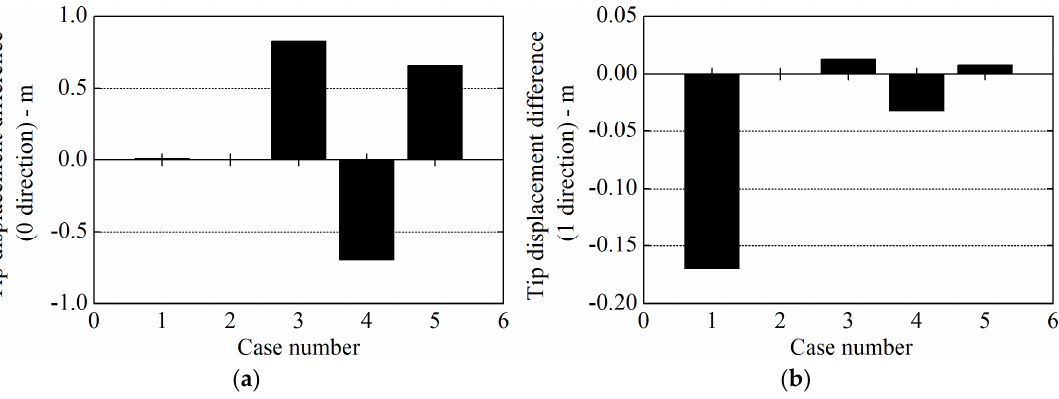
Figure 13. Comparison of different tip displacement results in 11.4 m/s: ( a ) 0 direction; and ( b ) 1 direction Case 1: Elastic Actuator Line Model (present study); Case 2: NREL’s FAST code; Case 3: